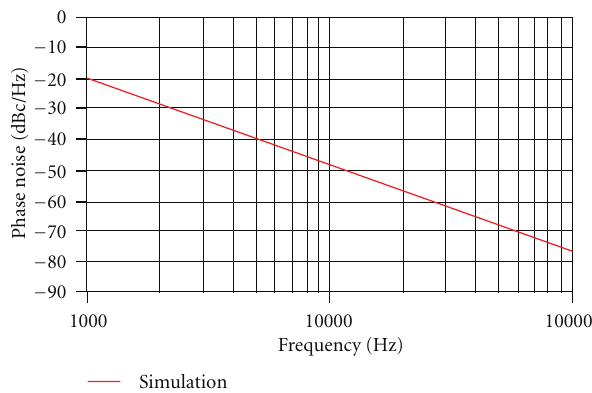
Figure 20: Phase noise simulation